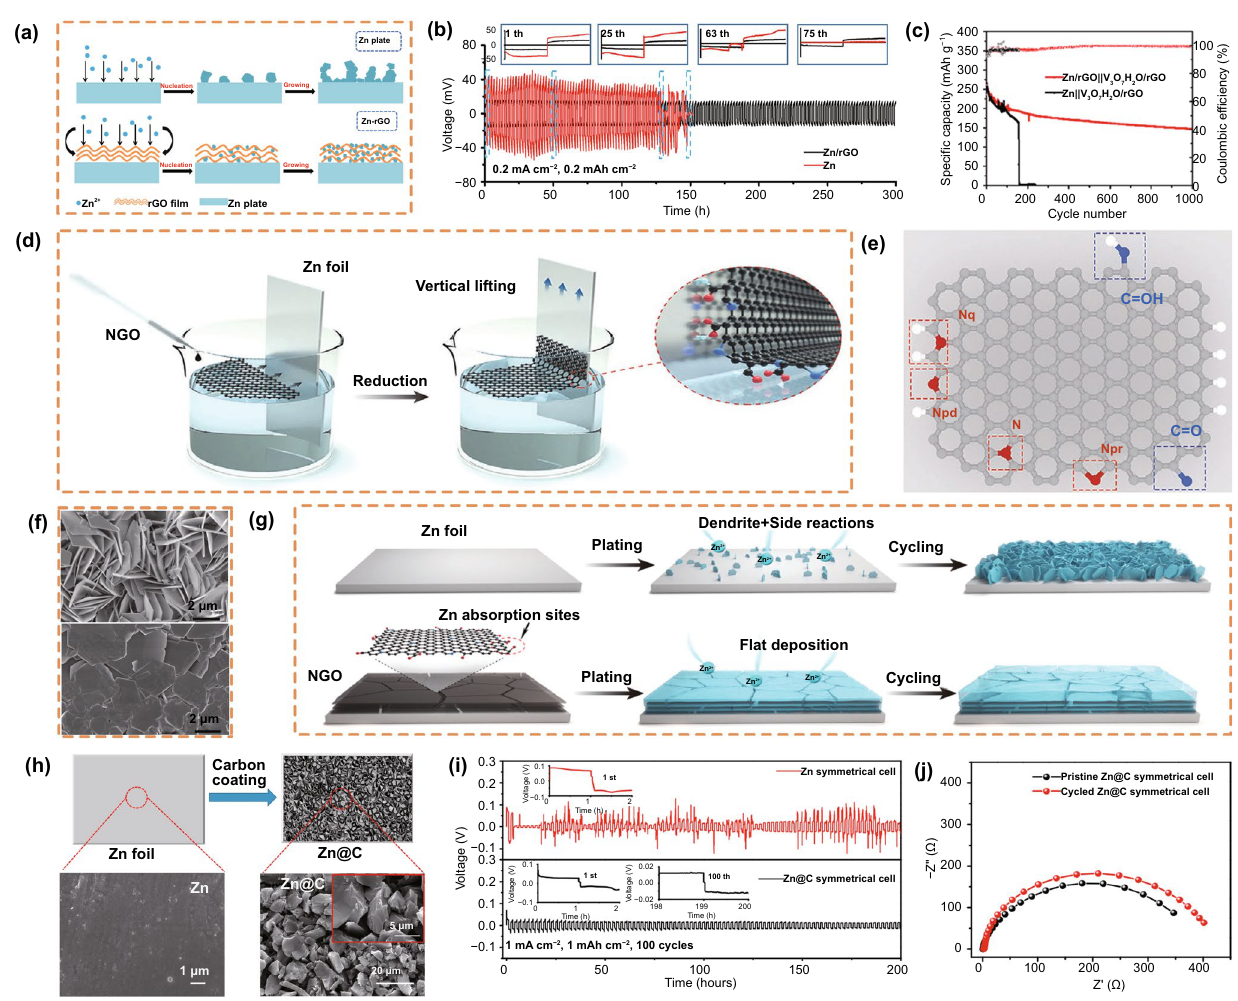
Fig. 4 a Schematic diagram illustrating the Zn plating behavior of the bare Zn and Zn/rGO anodes. b Cycling performance of symmetrical cells using Zn/rGO and a bare Zn plate at 0.2 mA cm −2 with a stripping/plating capacity of 0.2 mAh cm −2 . Copyright 2018 American Chemical Soci- ety [87]. d Schematic illustration of the fabrication of ultrathin graphene layers on ZF. e Configuration of N- and O-doped graphene. f Top-view SEM images of a bare ZF electrode and NGO after plating at 1 mAh cm −2 . g Schematic illustration of Zn plating on a bare ZF and NGO@Zn electrode. Copyright 2021 Wiley-VCH [74]. h Schematic illustration of a Zn@C film and SEM images of the Zn and Zn@C. i Stripping/plating performance of Zn and Zn@C cells at 1 mA cm −2 with 1 mAh cm −2 . j Nyquist plots of the Zn@C symmetrical cell before and after 100